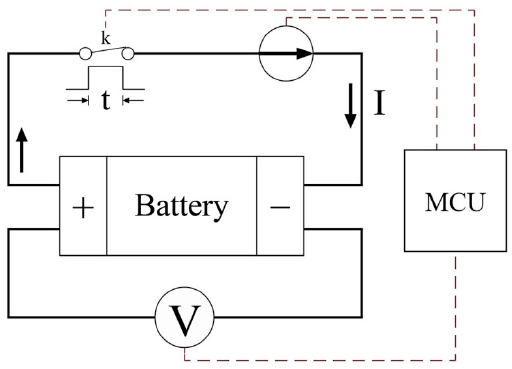
Figure 2 . Internal resistance detection schematic.